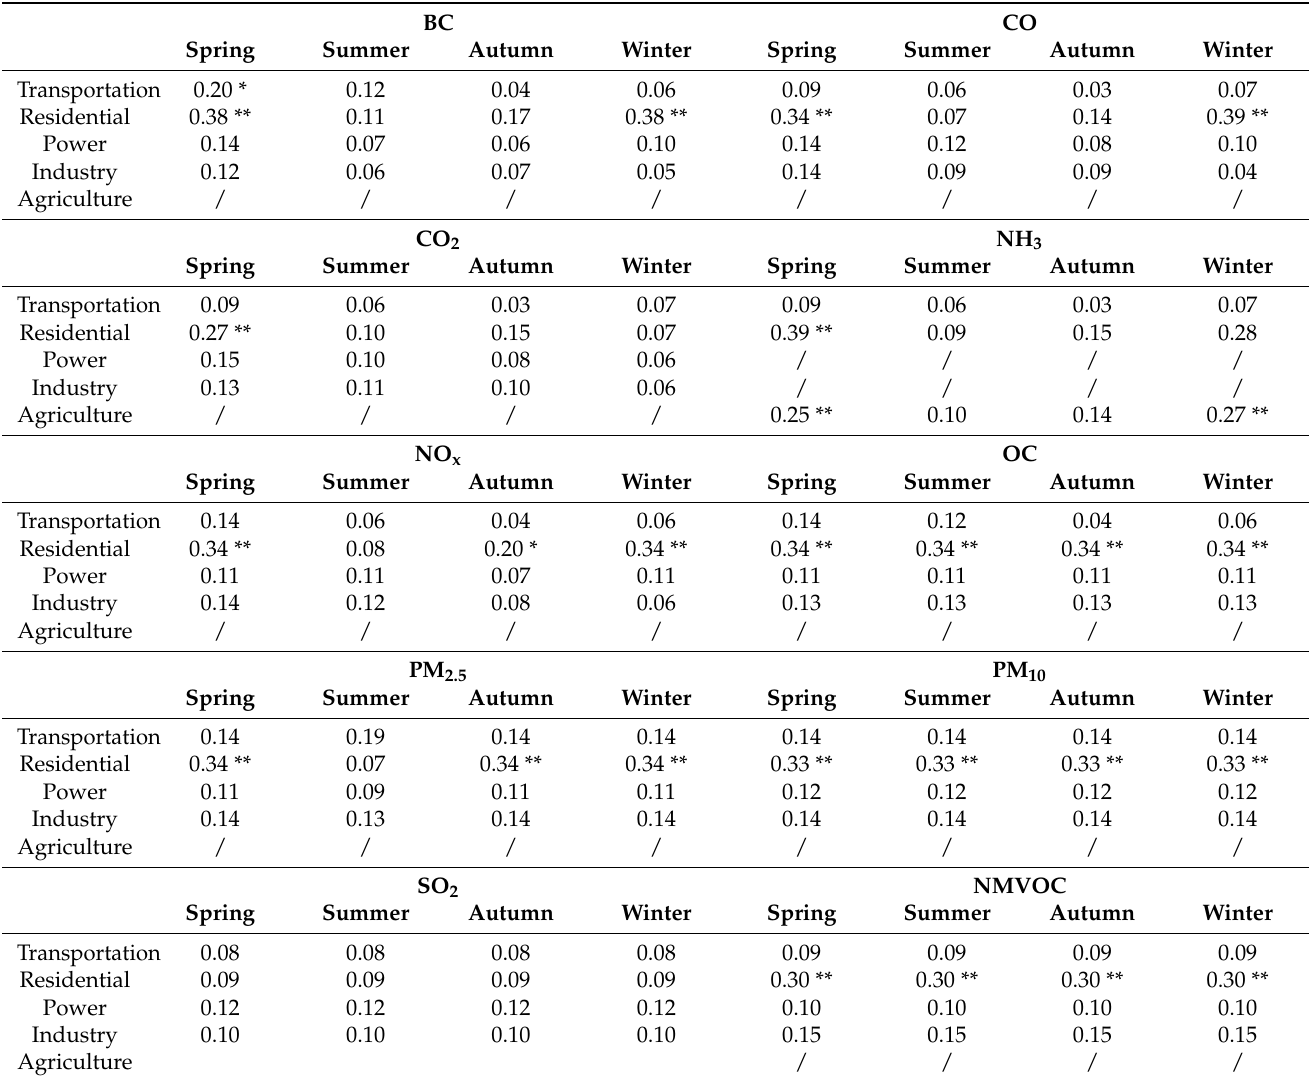
Seasonal detection results of different sectoral emissions for NCon(NO x ) and